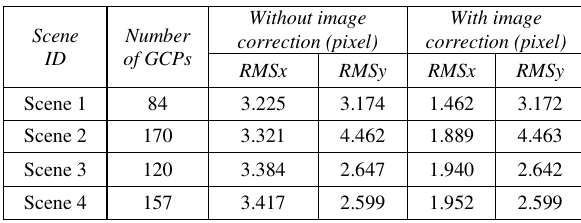
Table 3. Image space residuals obtained in georeferencing of FORMOSAT-2 imagery with and without IO